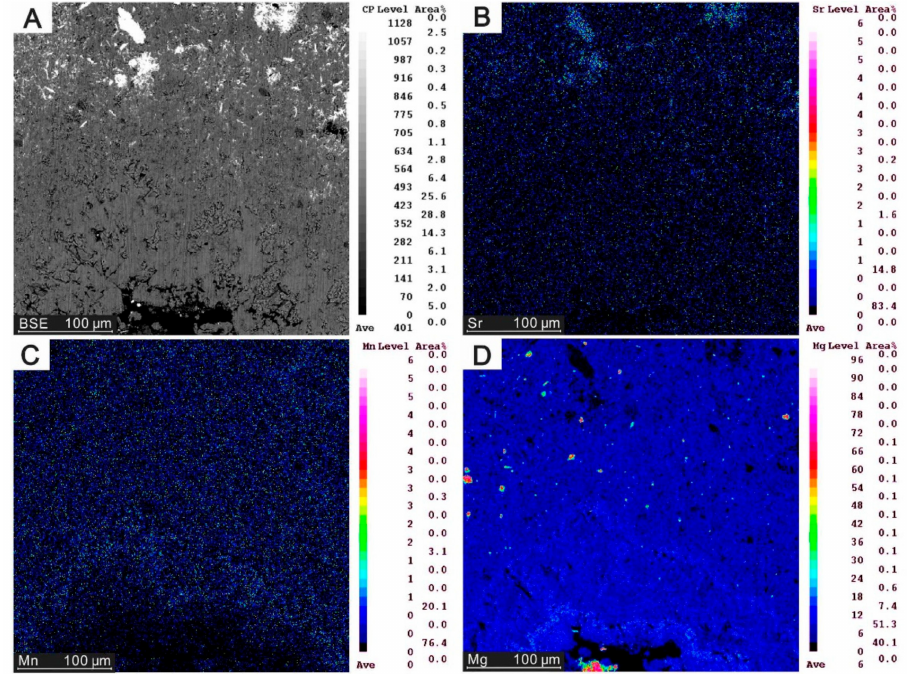
Figure 4. Back-scattered electron (BSE) image ( A ) and electron microprobe element maps ( B – D ) of a selected area in 4193 carbonate. The microcrystals in 4193 carbonate are composed of barite and low-magnesium calcite, while the sparry rim is dominated by low-magnesium calcite (A). Strontium and Mn contents are uniform in calcite and strontium contents are higher in barite (B, C); Magnesium contents in the sparry rim are higher than that of micrite